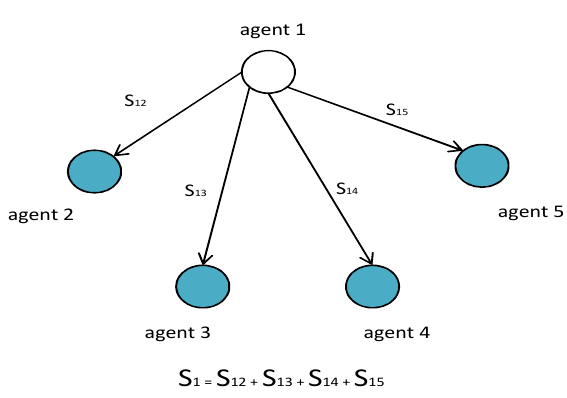
S in ECGOA. Figure 3. Calculation of S S in ECGOA. i in i i